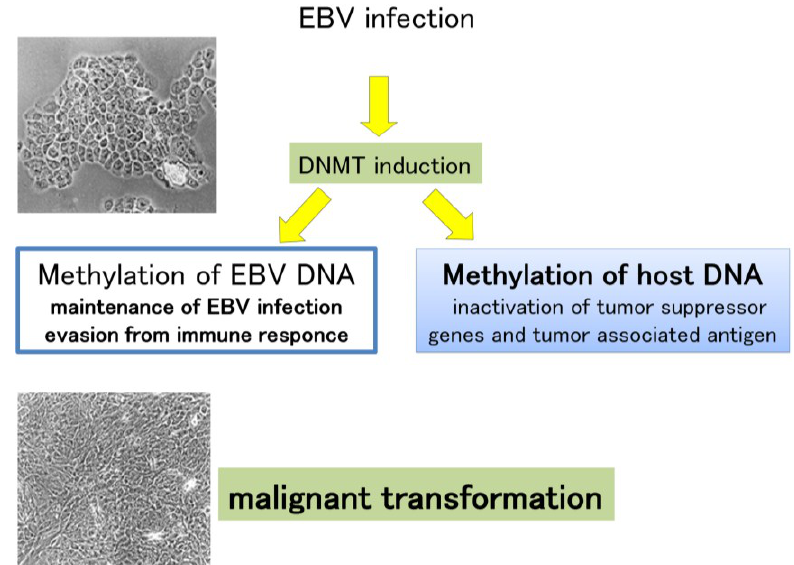
Figure 3. Aberrant DNA methylation might lead to the development and progression of Epstein-Barr virus (EBV)-associated gastric carcinoma. DNMT, DNA